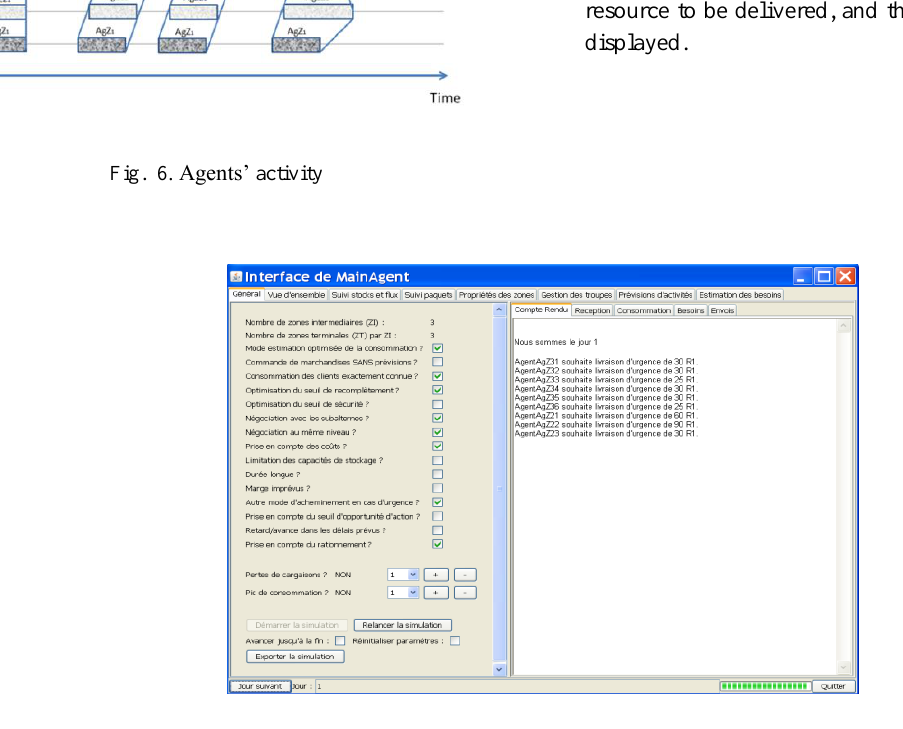
Fig. 7. Example of request